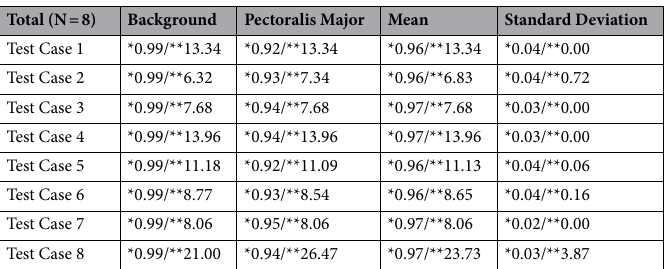
Table 2. Mean-Dice and Hausdorff scores for Pectoralis Major muscle segmentation. *Mean-Dice Scores/**Hausdorff